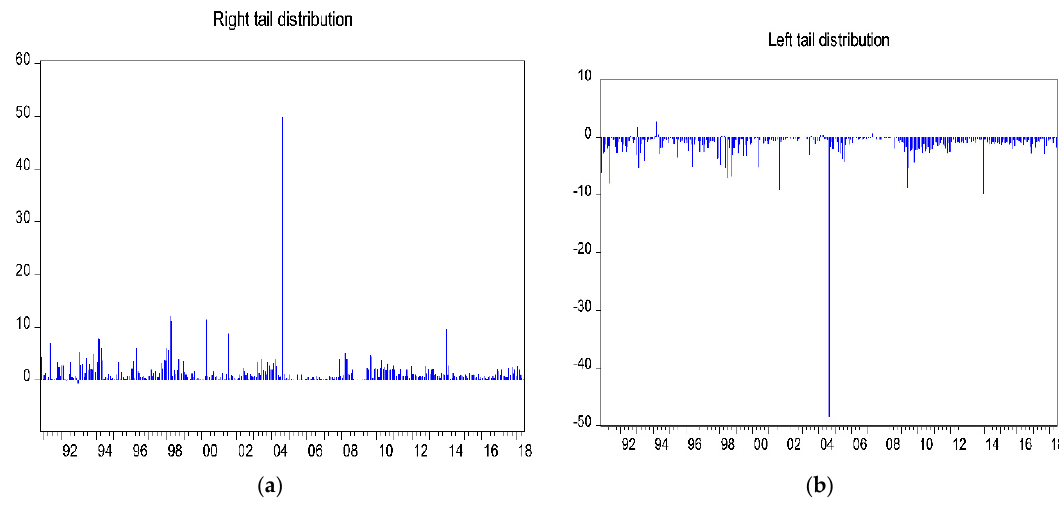
Figure 2. ( a ) Log returns of the right tails; ( b ) log returns of the left tails.